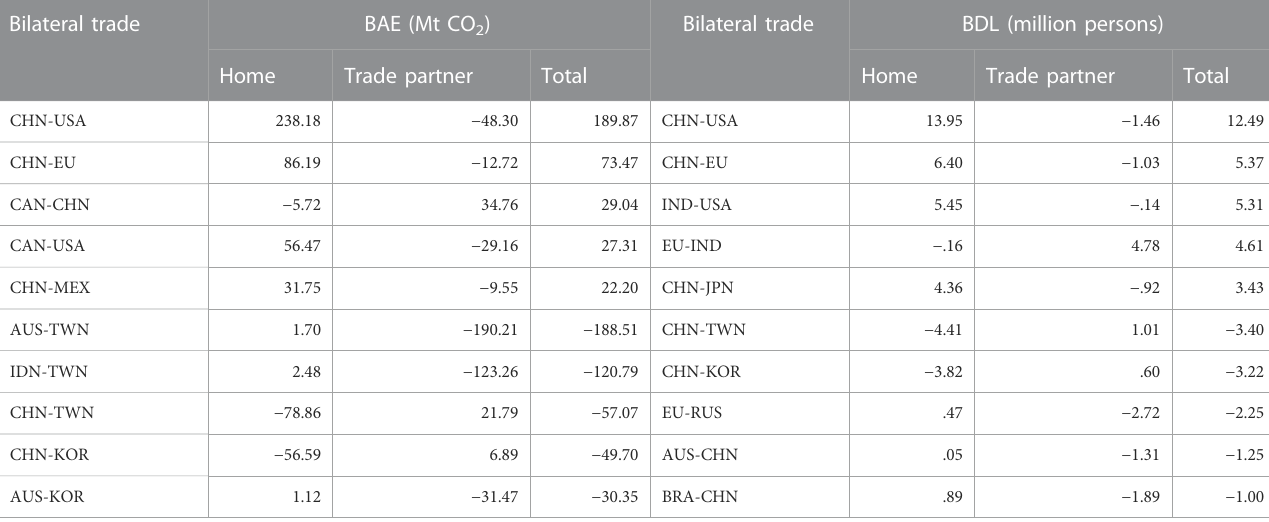
TABLE 5 Environmental and employment impacts of the selected bilateral trade in 2014. Bilateral trade BAE (Mt CO 2